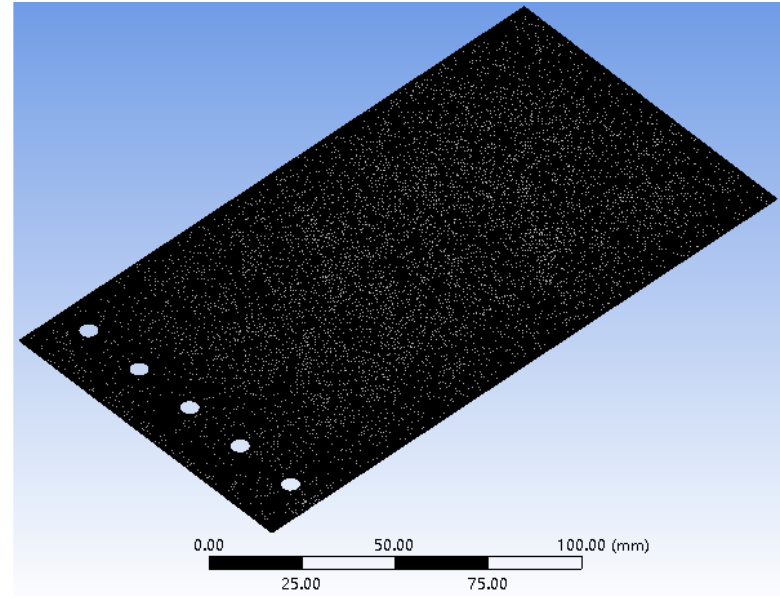
Figure 13. The finite element mesh of the FLS model.